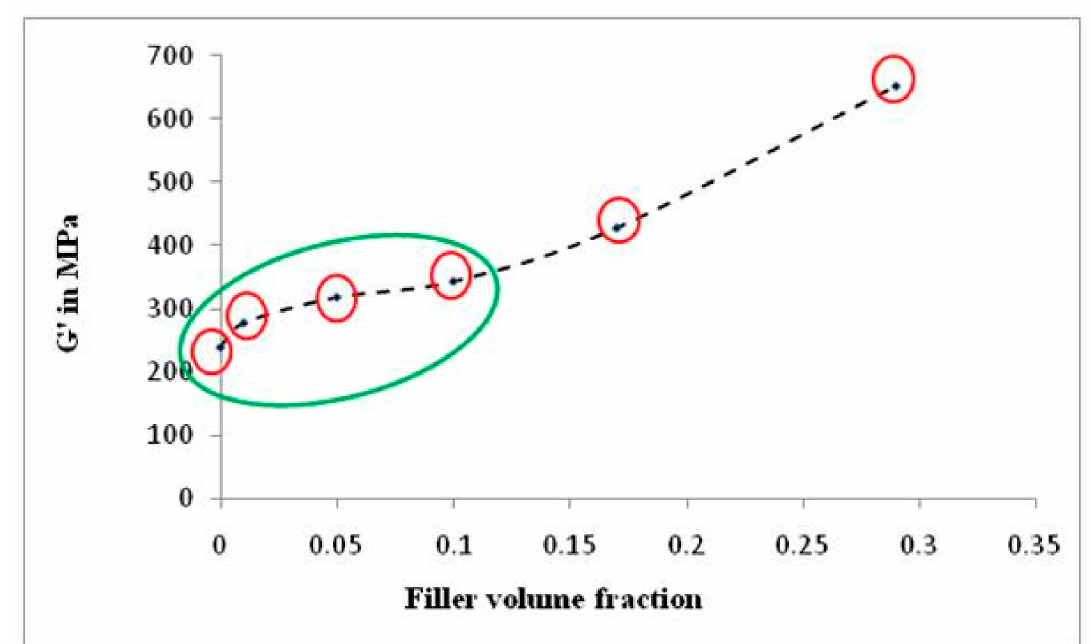
Figure 7. Plot of dynamic modulus (G (cid:48) ) vs. filler volume fraction ( φ ) in shear mode.